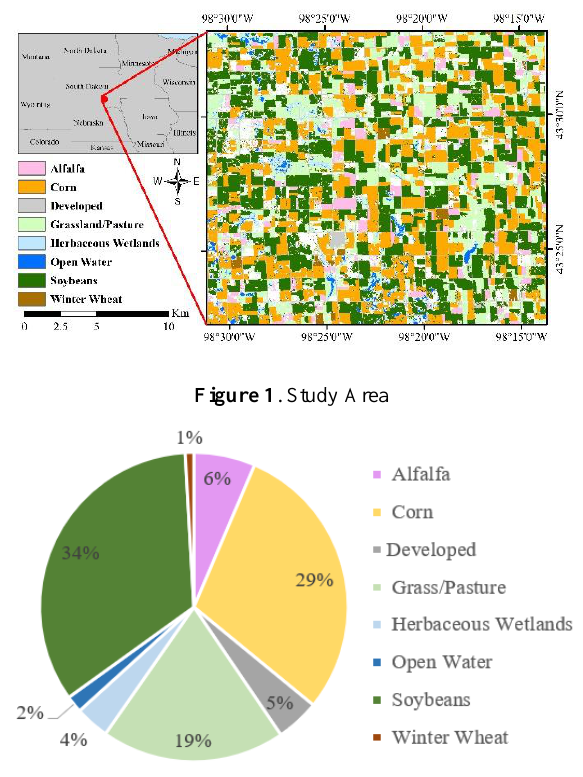
Figure 2 . The ratio of land uses in the study